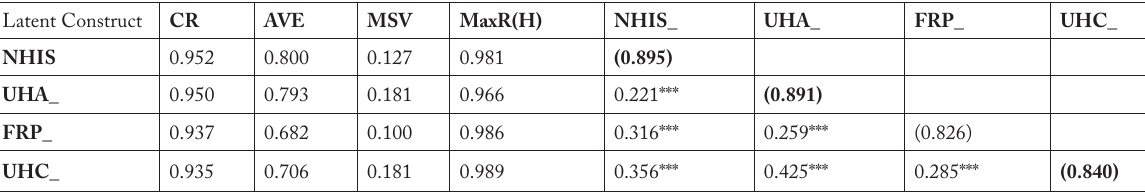
Table 6. Discriminant validity test.